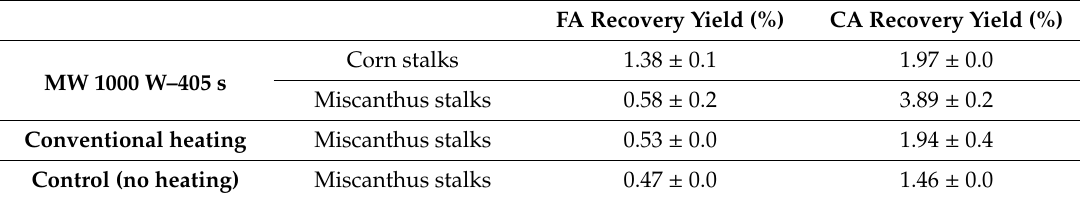
Table 7. CA and FA yields after optimum microwave conditions for corn and miscanthus stalks, and after control and conventional treatment for miscanthus stalks. FA and CA yields are expressed in %: mg phenolic acid release / mg initial phenolic